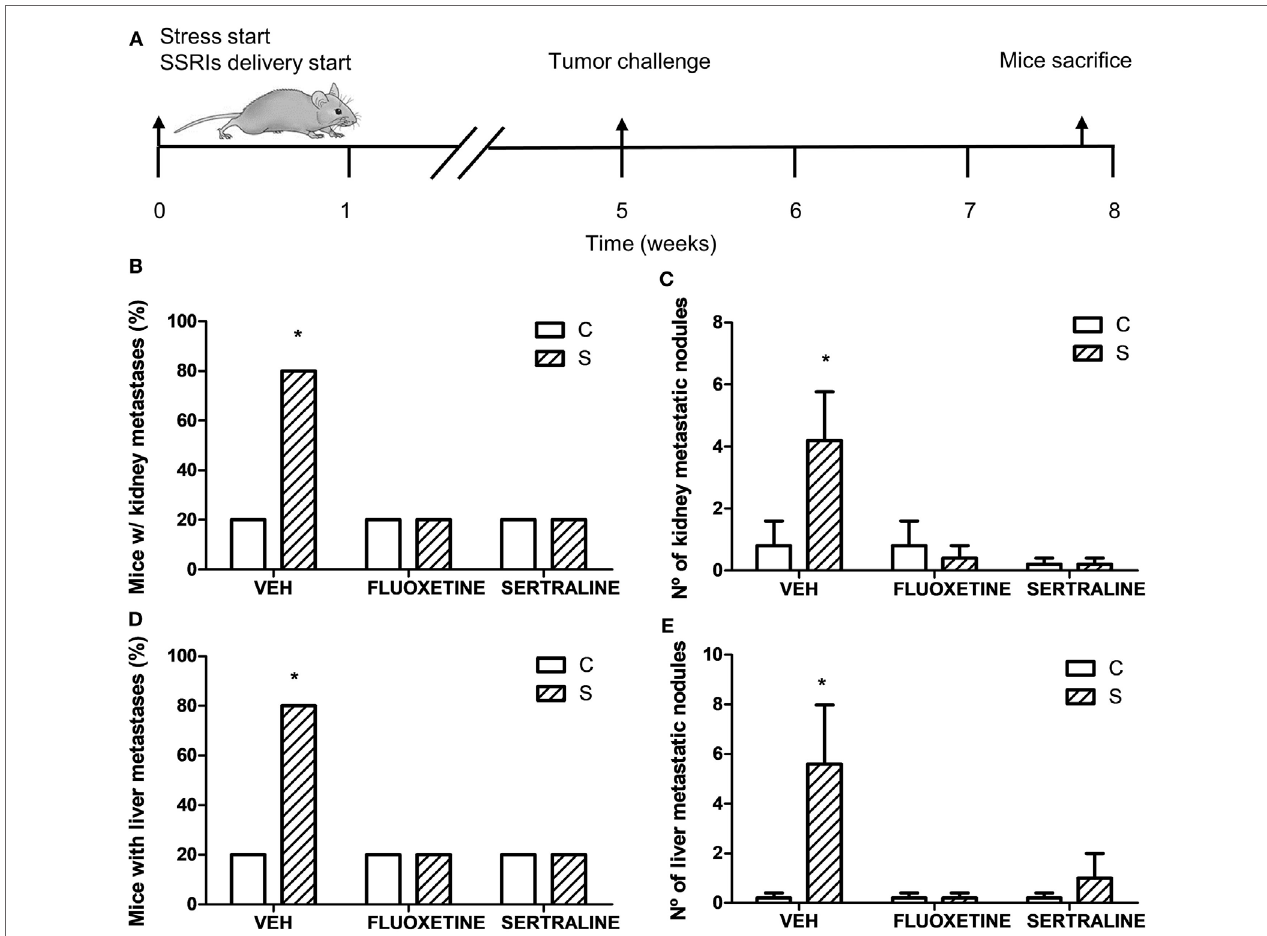
FigUre 5 | Spontaneous metastasis assay in mice from different experimental groups. (a) Schematic representation of experimental protocol. 19 days post subcutaneous injection of EL4 cells in mice from different experimental groups, mice were sacrificed and percentage of mice with metastatic nodules in kidney (B) or liver (D) was calculated. Also, number of metastatic nodules in kidney (c) or liver (e) was assessed. Values are expressed as mean ± SEM. n = 5 mice per group. * p < 0.05 respect to control